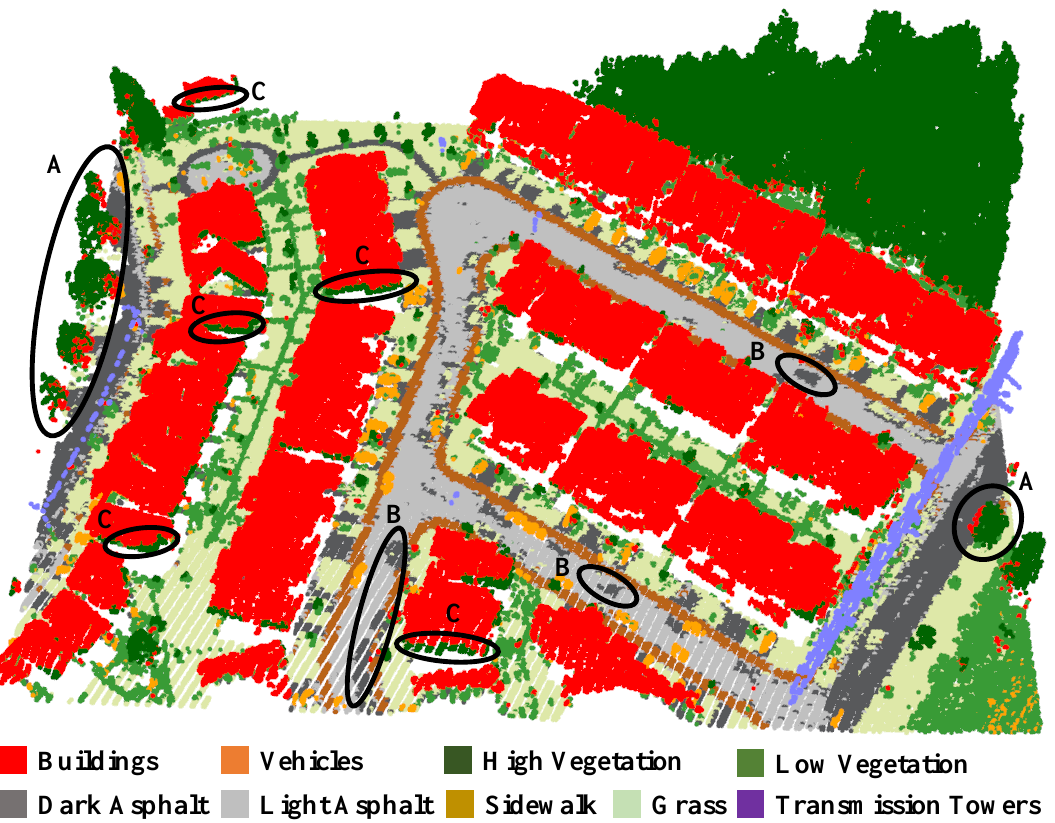
Figure 17. Final LiDAR mapping: black ovals represent examples of misclassification (A: high vegetation as buildings, B: light asphalt as dark asphalt, C: buildings as high